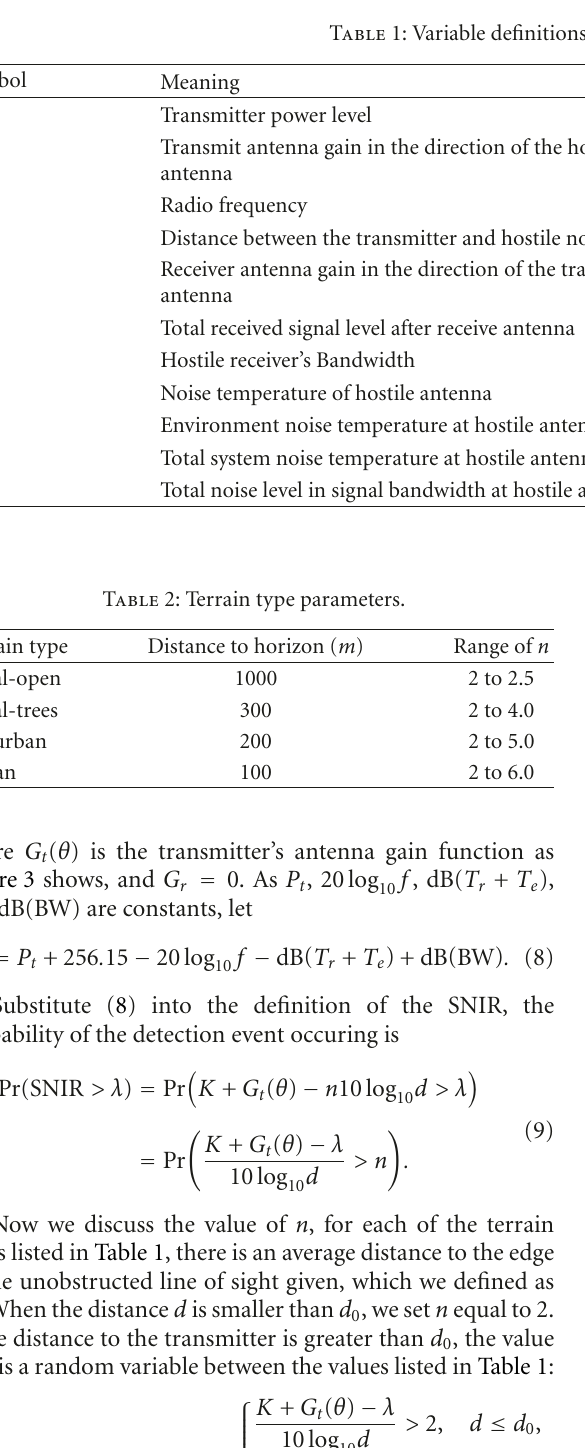
figure, di ff erent colors mean di ff erent probability values. As omnidirectional antennas radiate signals in all directions equally, the contour lines are almost circles in Figure